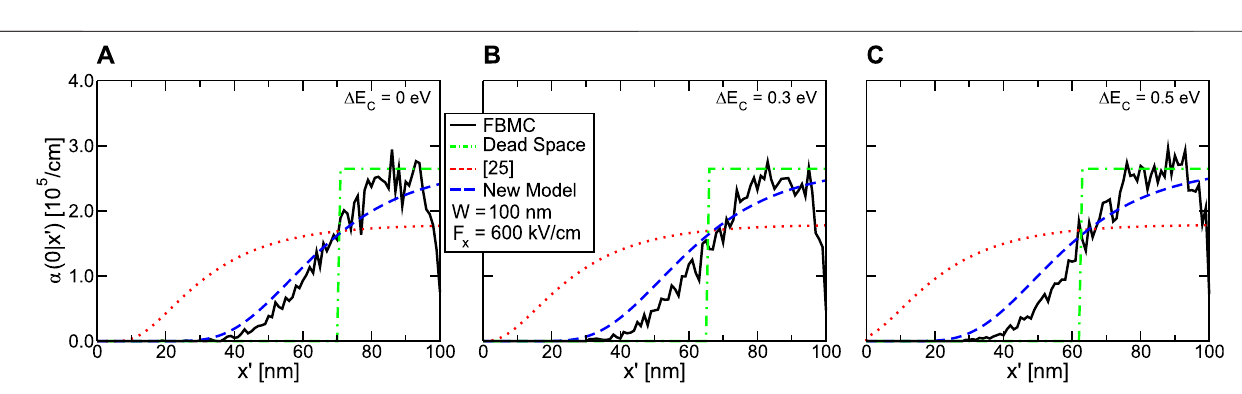
Frontiers in Physics |